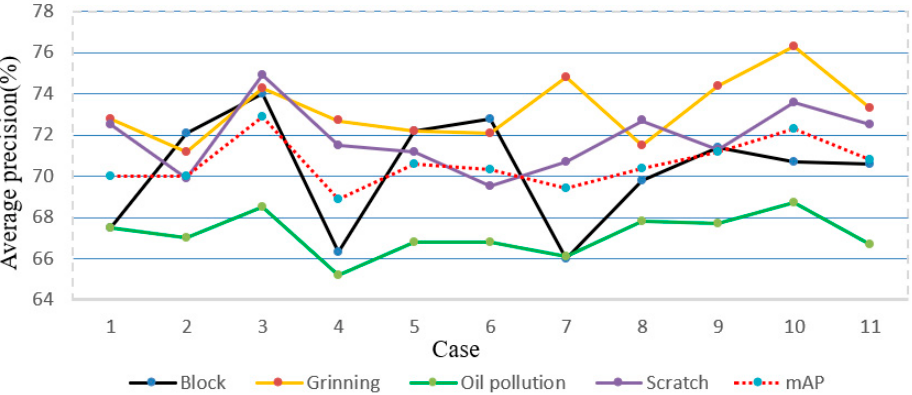
Figure 10. The performance of the network for the testing set.